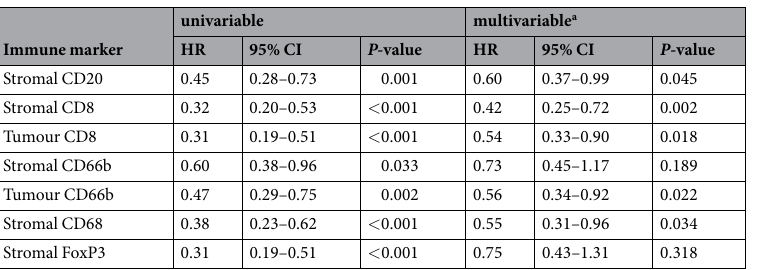
Table 3. Cox regression analyses of infiltrating immune cells in predicting survival of CRC patients. a The Cox regression multivariable models included one categorical immune parameter, age, localisation and stage, and were stratified by sex (n = 217). Abbreviations: HR, hazard ratio; CI, confidence